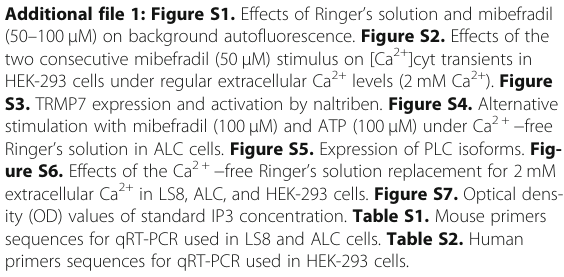
Additional file 1: Figure S1. Effects of Ringer ’ s solution and mibefradil (50 – 100 μ M) on background autofluorescence. Figure S2. Effects of the two consecutive mibefradil (50 μ M) stimulus on [Ca 2+ ]cyt transients in HEK-293 cells under regular extracellular Ca 2+ levels (2 mM Ca 2+ ). Figure S3. TRMP7 expression and activation by naltriben. Figure S4. Alternative stimulation with mibefradil (100 μ M) and ATP (100 μ M) under Ca 2+ −